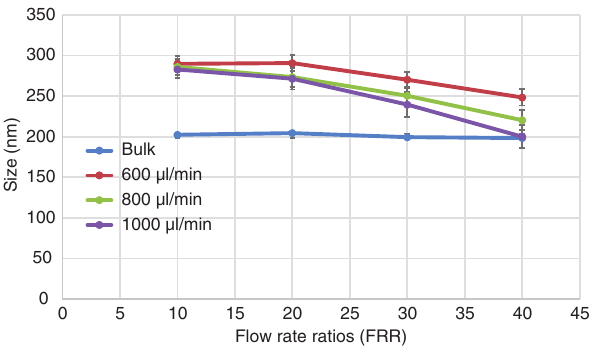
Figure 1: Size of PLGA nanoparticles as a function of aqueous organic flow rate ratio and phase ratio for continuous flow and batch nanoprecipitation method. Data are presented as means ± SD, n = 3.